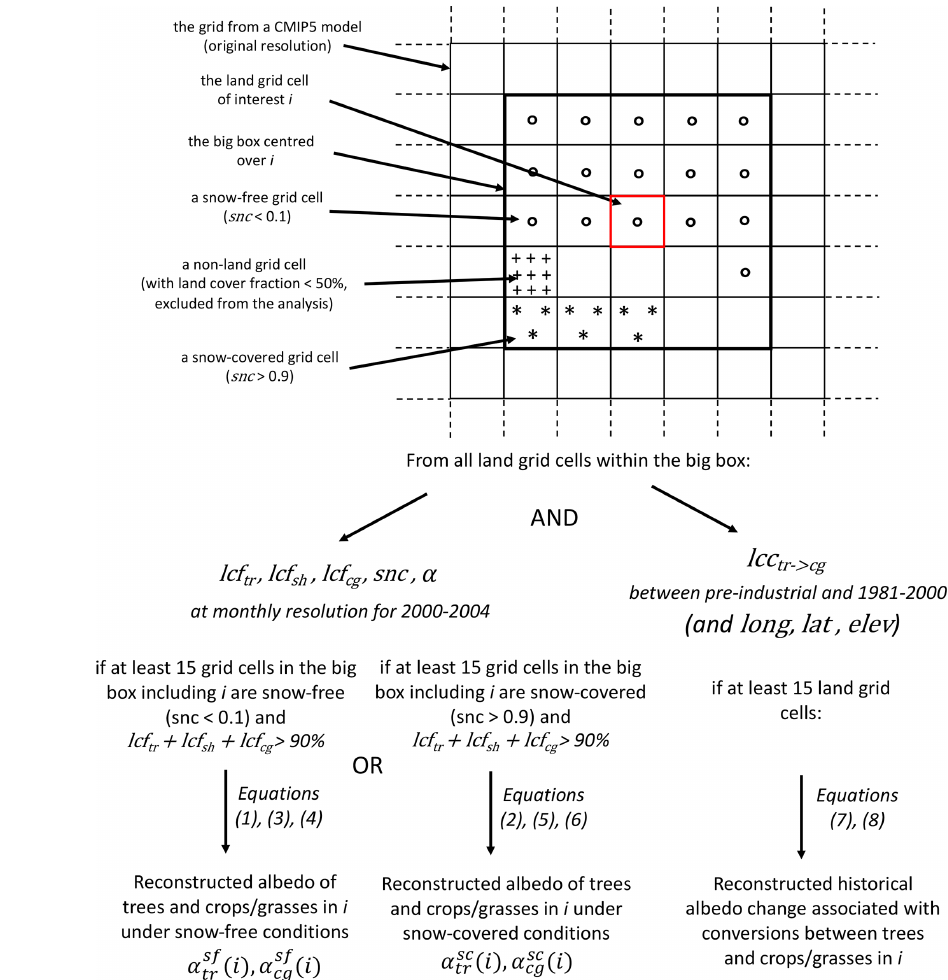
Figure 1. Description of the two employed reconstruction methodologies; snc stands for snow cover fraction, α for albedo, lcf for land cover fraction, and lcc for land cover conversion. The suffixes tr, sh, and cg stand for trees, shrubs, and crops–grasses, respectively, with long for longitude, lat for latitude, and elev for